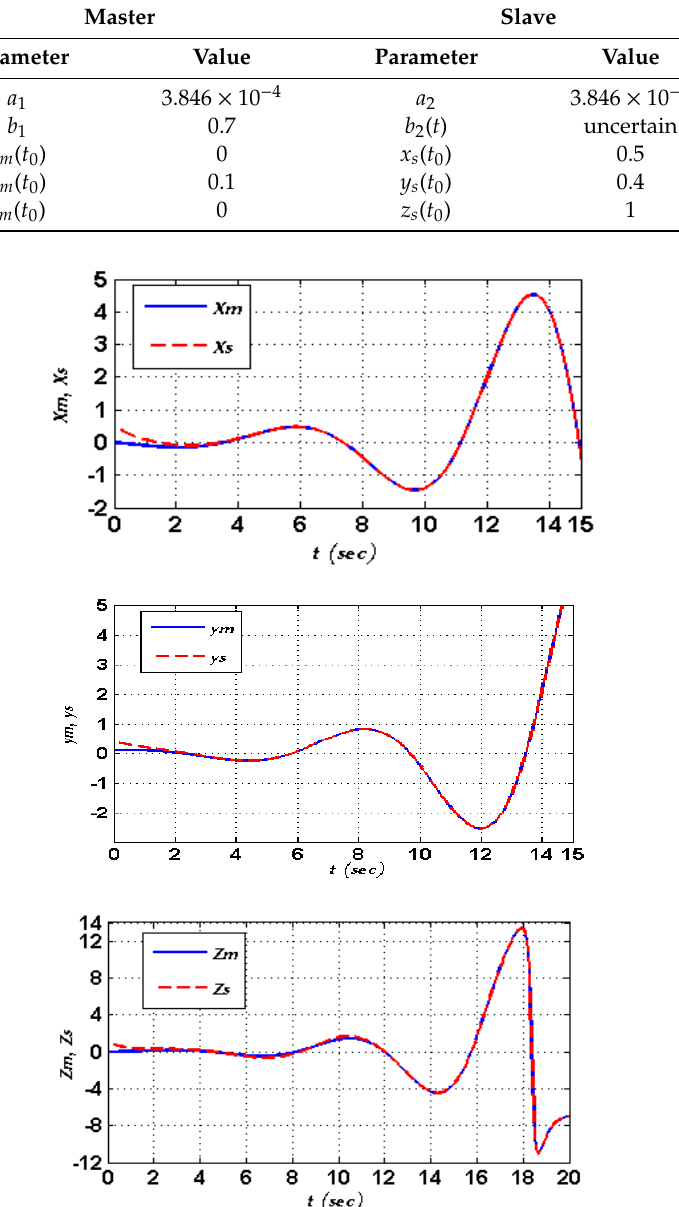
Figure 4. States Figure 4. States synchronization.